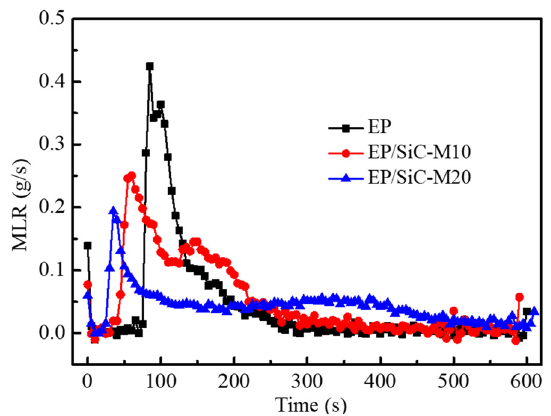
Figure 9: Mass loss rate versus time curves of EP and composites EP/SiC - M.